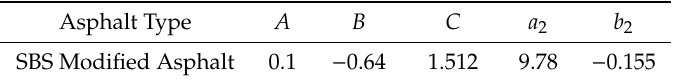
Table 9. Fitting parameters of linear model under di ff erent